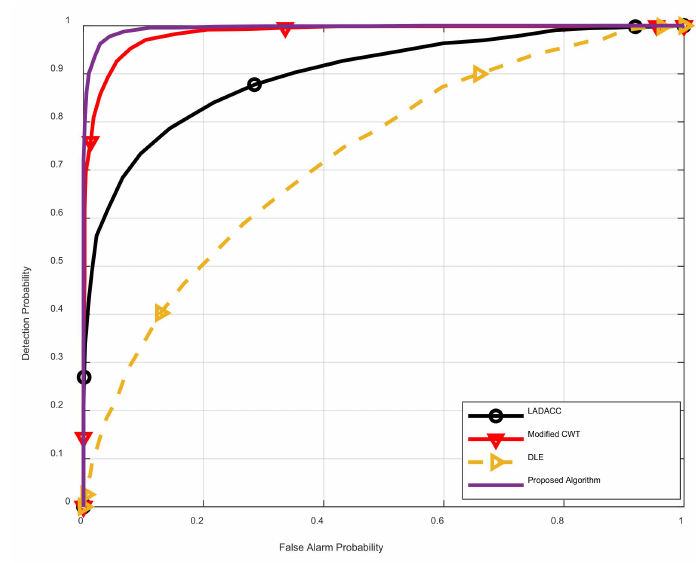
Figure 13. ROC at − 10 dB under AWGN channel.